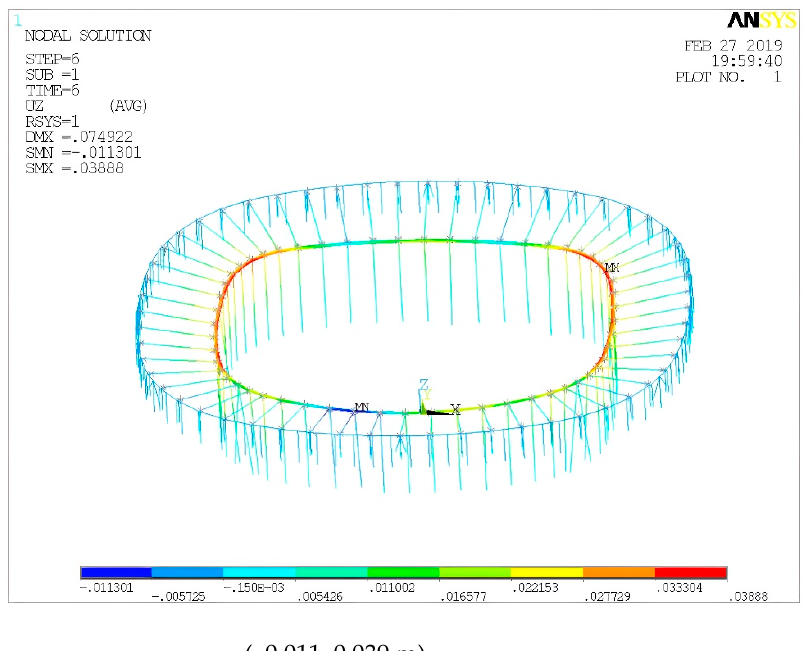
Figure 35. Vertical deformation Uz (m) of C6. The radial deformation Ux of 56 CR nodes under each tension calculation condition through local cylindrical coordinate system was drawn as a deformation curve, which is shown in Figure 36. From C1 to C3, the CR radial deformation at the minor axis expands outward to 144 mm. The CR radial deformation at 45 ◦ is relatively small and gradually decreases, and at the long axis it remains small and stable. From C4 to C6, CR radial deformation gradually decreases and finally reaches about 0, which means that the plane configuration of the CR reaches the designed one when tie-down tension is completed.